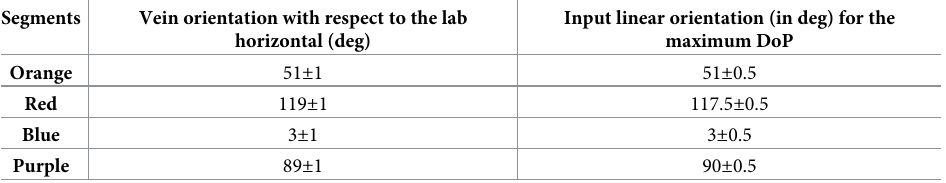
Table 1. Correlations between the vein orientation and the maximum DoP value for different veins in the Hedera maroccana leaf (orange, red, blue and purple segments in Fig